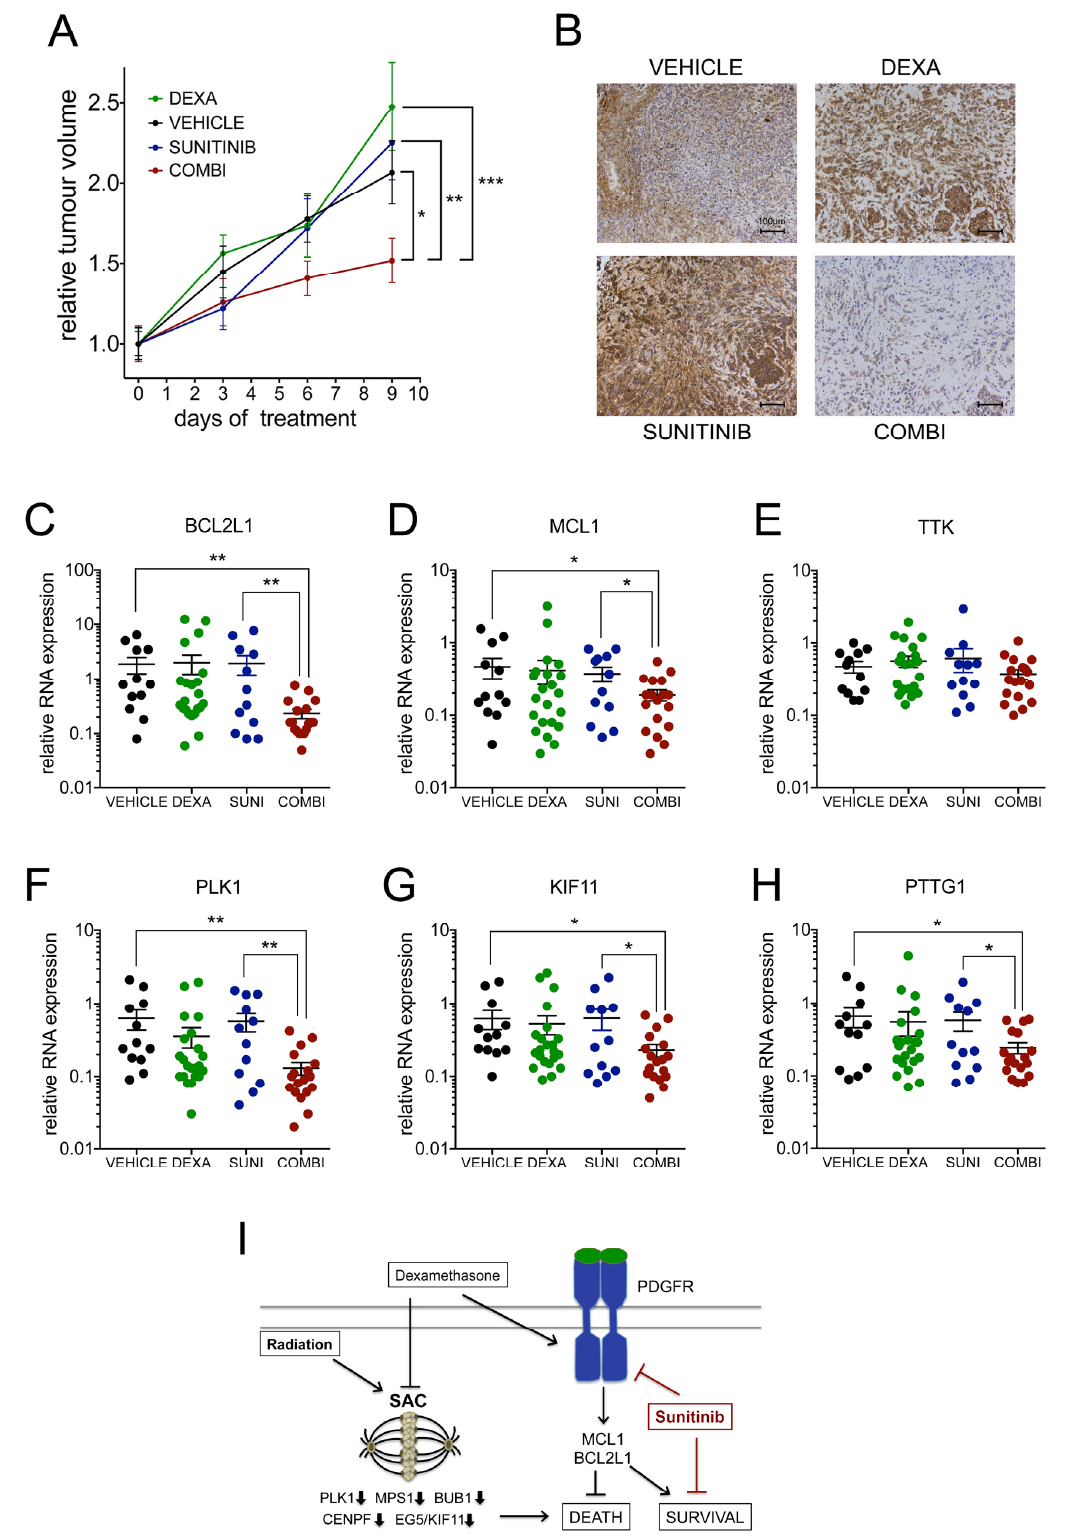
Figure 7. Dexamethasone sensitizes to sunitinib in vivo. ( A ) Mean tumour volumes ± SEM of mice ( n ≥ 6 mice/group) treated as indicated: sunitinib (40 mg/kg/qd), DEXA (0.3mg/kg/qd). ( B ) IHC for phospho-SRC/SFK in the indicated tumours; scale bar 100 µ m. ( C – H ) qRT-PCR analysis for the indicated genes of tumours from mice treated as described in ( A ). Data are from two experimental repeats of n = 6–11 tumours per group represented as scatter dot blot; the mean ± SEM is indicated. ( I ) Model of DEXA induced signalling that creates vulnerability for sunitinib. * p < 0.05, ** p < 0.01, *** p <